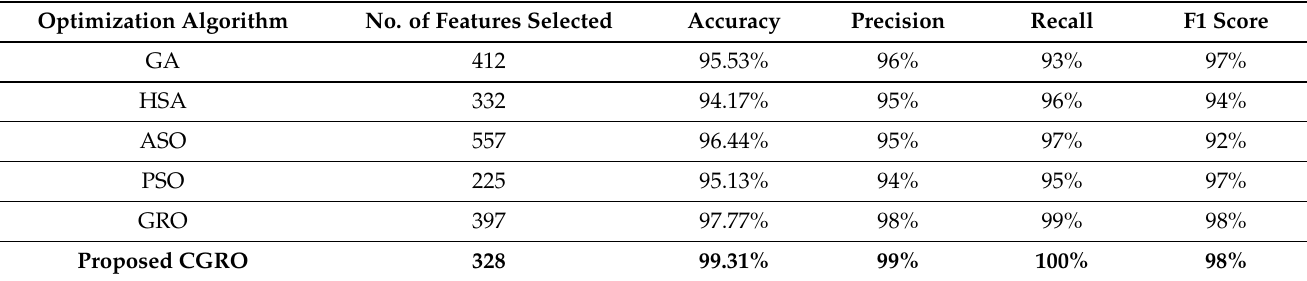
Table 6. Comparative study of different optimization algorithms with proposed CGRO-based FS algorithm on the COVID CT-Dataset. The performance of proposed algorithm has been highlighted in bold text format. Optimization